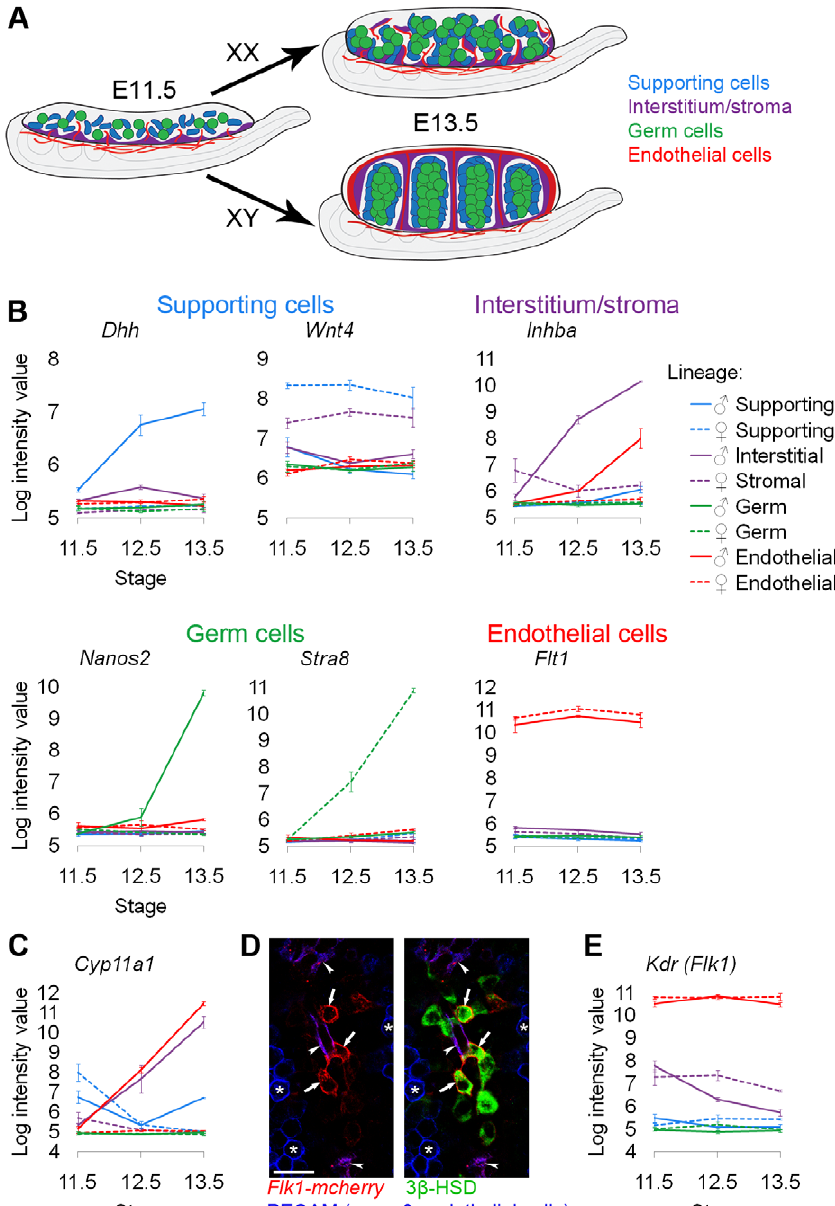
Figure 1. Sorted cell lineages and microarray validation. (A) Illustration of the developing XX and XY gonad with supporting cells (blue), interstitial/stromal cells (purple), germ cells (green), and endothelial cells (red). (B, C, and F) Graphs of the log-transformed, normalized intensity values from the microarrays for control genes known to be specific to each lineage. The color for each lineage is conserved in all figures and matches the illustration (A), with XX ( R ) values shown as dashed lines, and XY ( = ) values shown as solid lines. The error bars are standard error of the mean (‘‘standard error’’) of the log transformed values. The Y-axis scale differs for each graph because each transcript cluster has its own intensity range. (B) The control genes were found in the expected lineage, except for (C) genes characteristic of Leydig cells. Leydig cell genes were highly expressed in both the interstitium (as expected) and the endothelial cell fraction. (D) Immunofluorescence of E13.5 XY gonads with Flk1-mCherry (red), PECAM1 (germ and endothelial cells, blue), and 3 b -HSD (Leydig cells, green). Arrowheads indicate Flk1-mCherry and PECAM1 double positive endothelial cells. Arrows indicate Flk1-mCherry positive, PECAM1 negative cells that were positive for 3 b -HSD, confirming aberrant reporter expression in some Leydig cells. Asterisks indicate germ cells positive for PECAM1 alone. Scale bar=25 m m. (E) The XY interstitial cells have very low expression of the endogenous Flk1 ( Kdr ) transcript at E13.5, supporting our conclusion that the Flk1-mCherry transgene is aberrantly expressed in Leydig cells. doi:10.1371/journal.pgen.1002575.g001 SOX9 protein (Figure S2C). Consequently, at least early in significance, it could also result from leaky expression of the a Sma-EYFP transgene. Thus, we excluded the a Sma-EYFP data development, it appears that a Sma-EYFP labels a heterogeneous population of cells containing supporting cells as well as from this analysis but have made the data available with the interstitial/stromal cells. While this finding may have biological rest of the microarrays.